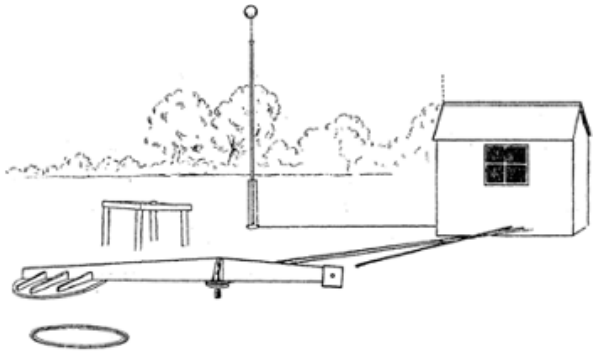
Figure 1. Wilson’s early hut (reproduced with permission from Wilson,